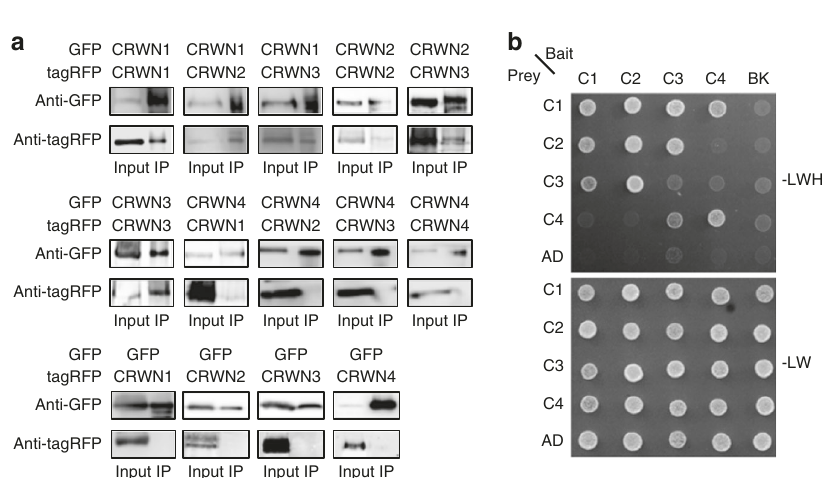
Fig. 1 CRWN expression and localization patterns in Arabidopsis thaliana . a β -Glucuronidase (GUS) signals in young fi rst leaves (8-day-old plant), adult fi rst leaves (14-day-old plant), and primary roots of pCRWN1 ::CRWN1-GUS, pCRWN2 ::CRWN2-GUS, and pCRWN3 ::CRWN3-GUS. Scale bars = 200 µ m (top), 1 mm (middle), and 100 µ m (bottom). b Confocal fl uorescence images of cotyledons and roots showing pCRWN1 ::CRWN1-EYFP in crwn1 , pCRWN2 :: CRWN2-EYFP in crwn2 , and pCRWN3 ::CRWN3-sGFP in crwn3 . EYFP and sGFP signals are green and propidium iodide signals are magenta. Scale bars = 10 µ m (top and middle) and 50 µ m (bottom). c Transmission electron micrograph of the nucleus in a root meristematic cell. Lower panel shows a magni fi ed image of the broken square in the upper panel. White arrowheads mark gold particle signals. Dotted and broken lines indicate outer and inner nuclear membranes, respectively. Red, orange, and blue areas indicate the nuclear lamina, internal, and external areas, respectively. Scale bars = 200 nm. d Number of gold particles in each area. Data are mean ± SEM. Signi fi cance was determined using unpaired two-sided t -test ( n = 5 individual nucleus). Each data point represents a cross mark. e Immuno fl uorescence images of nuclear surface and nuclear interior. Immunostaining signals are green and DAPI signals are magenta in the merged panel. Scale bar = 5 µ m. f Confocal fl uorescence images of root epidermal cells in the elongation zone. Scale bar = 5 µ m. g STED images of nuclei isolated from 7-day-old seedlings. Lower panels are magni fi ed images of the area indicated by the small square in the upper panels. Scale bars = 5 µ m (top) and 1 µ m (bottom).